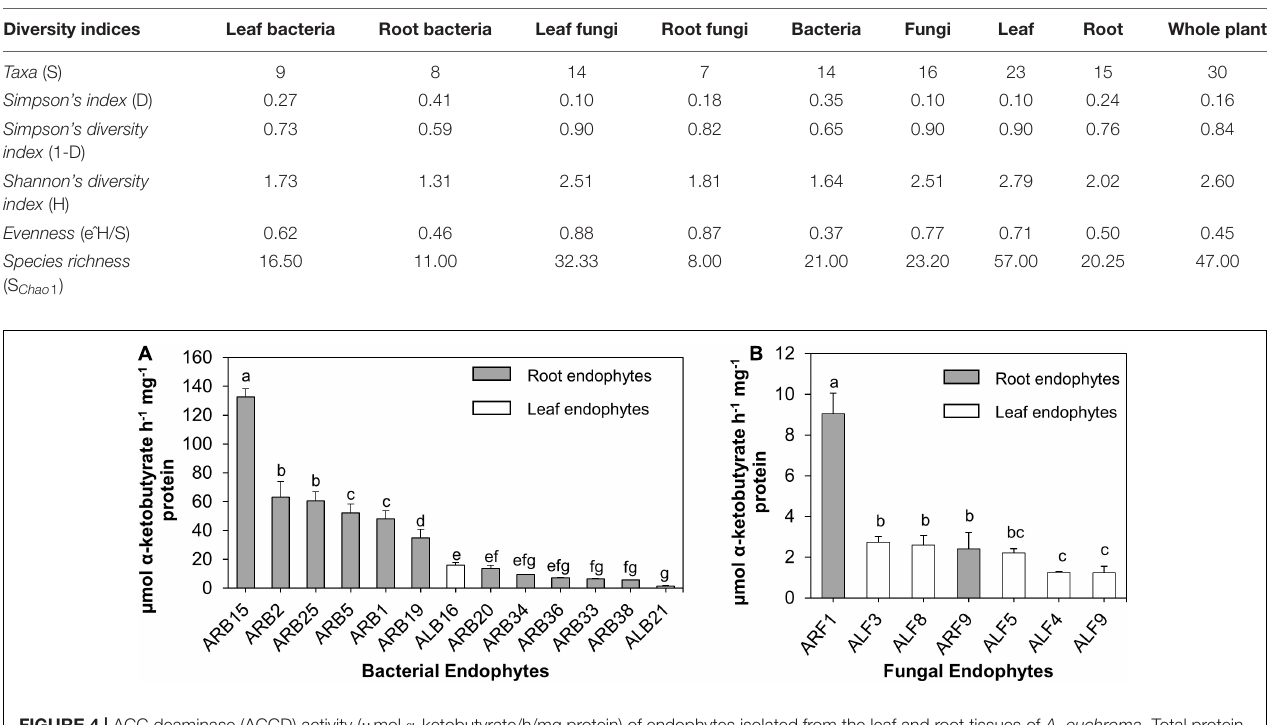
FIGURE 4 | ACC deaminase (ACCD) activity ( µ mol α -ketobutyrate/h/mg protein) of endophytes isolated from the leaf and root tissues of A. euchroma . Total protein after cell lysis was measured using Bradford assay. (A) ACCD activity of bacterial endophytes and (B) fungal endophytes. Bars with different alphabets indicate a significant difference ( p < 0.05) as calculated using Duncan’s multiple-range test. Error bars indicate standard deviation ( n =